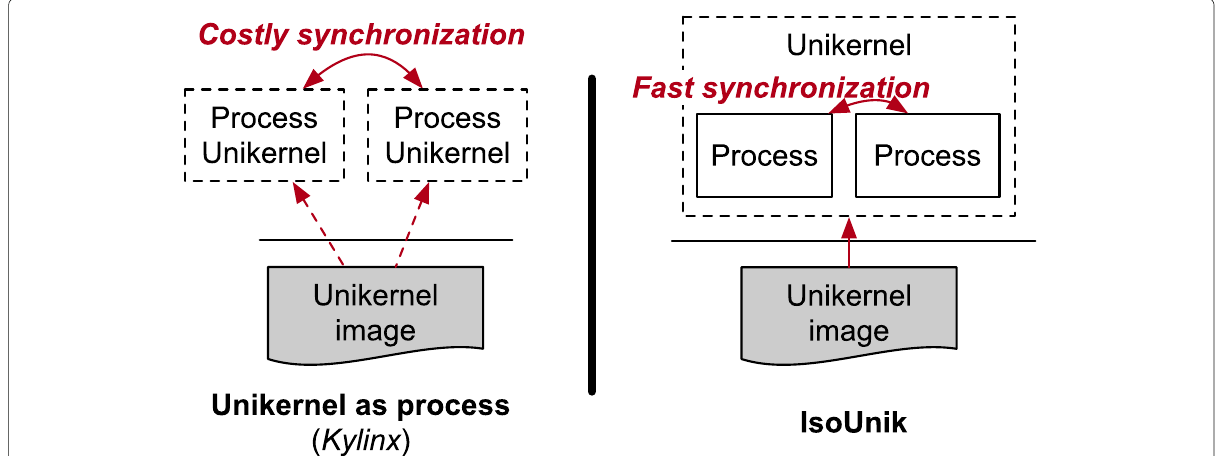
Fig. 1 Design comparision. Prior solution uses multi-unikernel to simulate multiple processes, which leads to higher